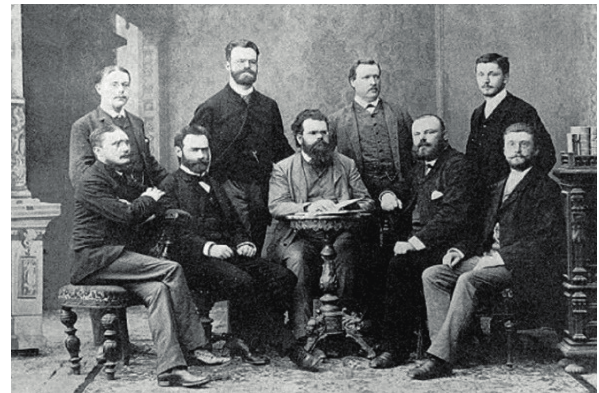
Figure 6. Photograph taken during Arrhenius´ visit of Ludwig Boltzmann in Graz in 1887. [111] Date: October 1887. Source Uni- versität Graz. Author unknown. Arrhenius is the fourth from the right, standing behind Boltzmann. Public domain. The photograph shows, standing from the left: Walther Nernst,. Heinrich Streintz, Svante Arrhenius, Richard Hiecke. Sitting, from the left: Eduard Aulinger, Albert von Ettingshausen, Ludwig Boltzmann, Ignaz Klemenčič, Victor